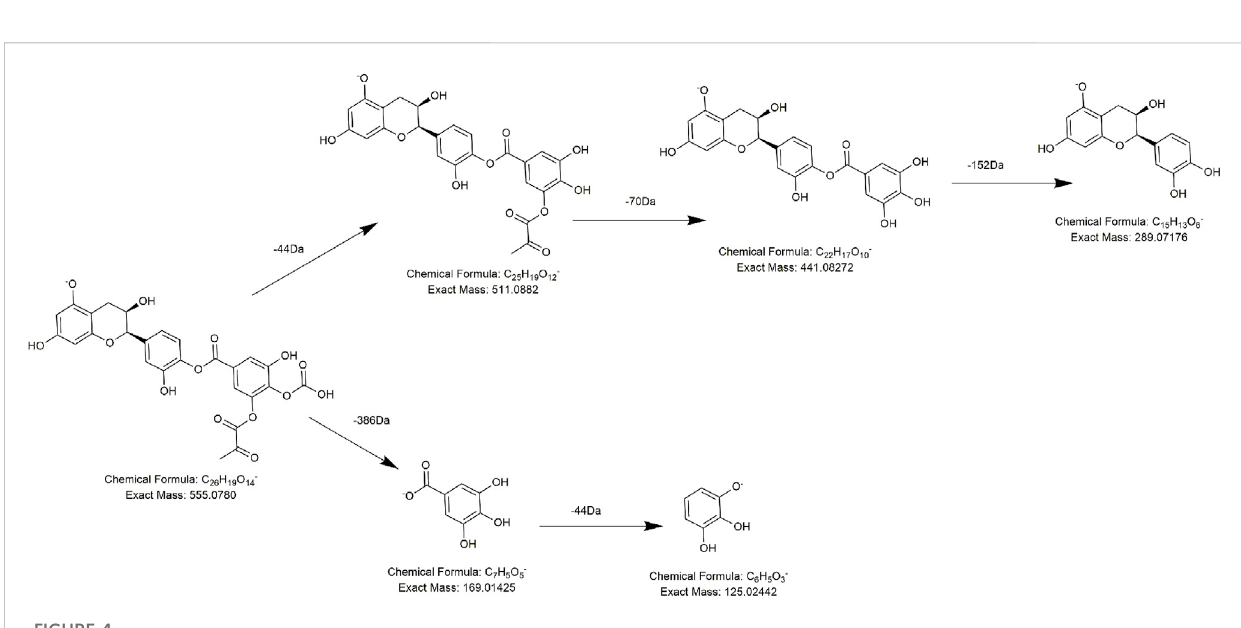
FIGURE 4 Proposed fragmentation pathways of FL15 (new